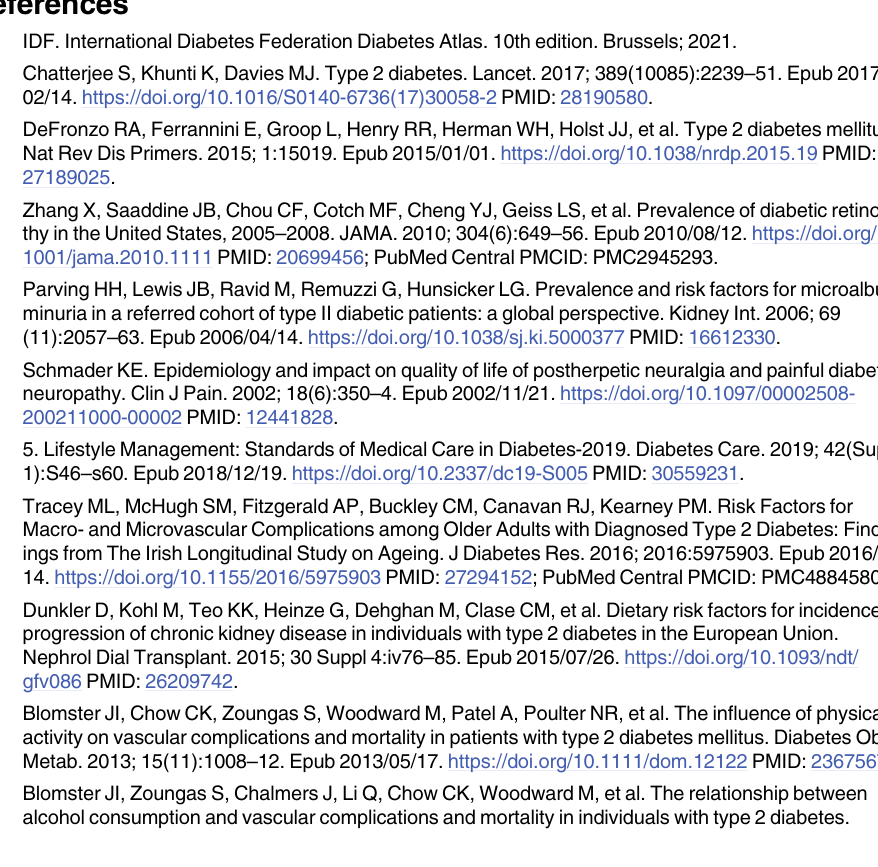
S15 Table. HRs (95% CIs) of microvascular complications according to the healthy lifestyle score among individuals with T2D using 2 competing risk models. CI, confidence interval; HR, hazard ratio; T2D, type 2